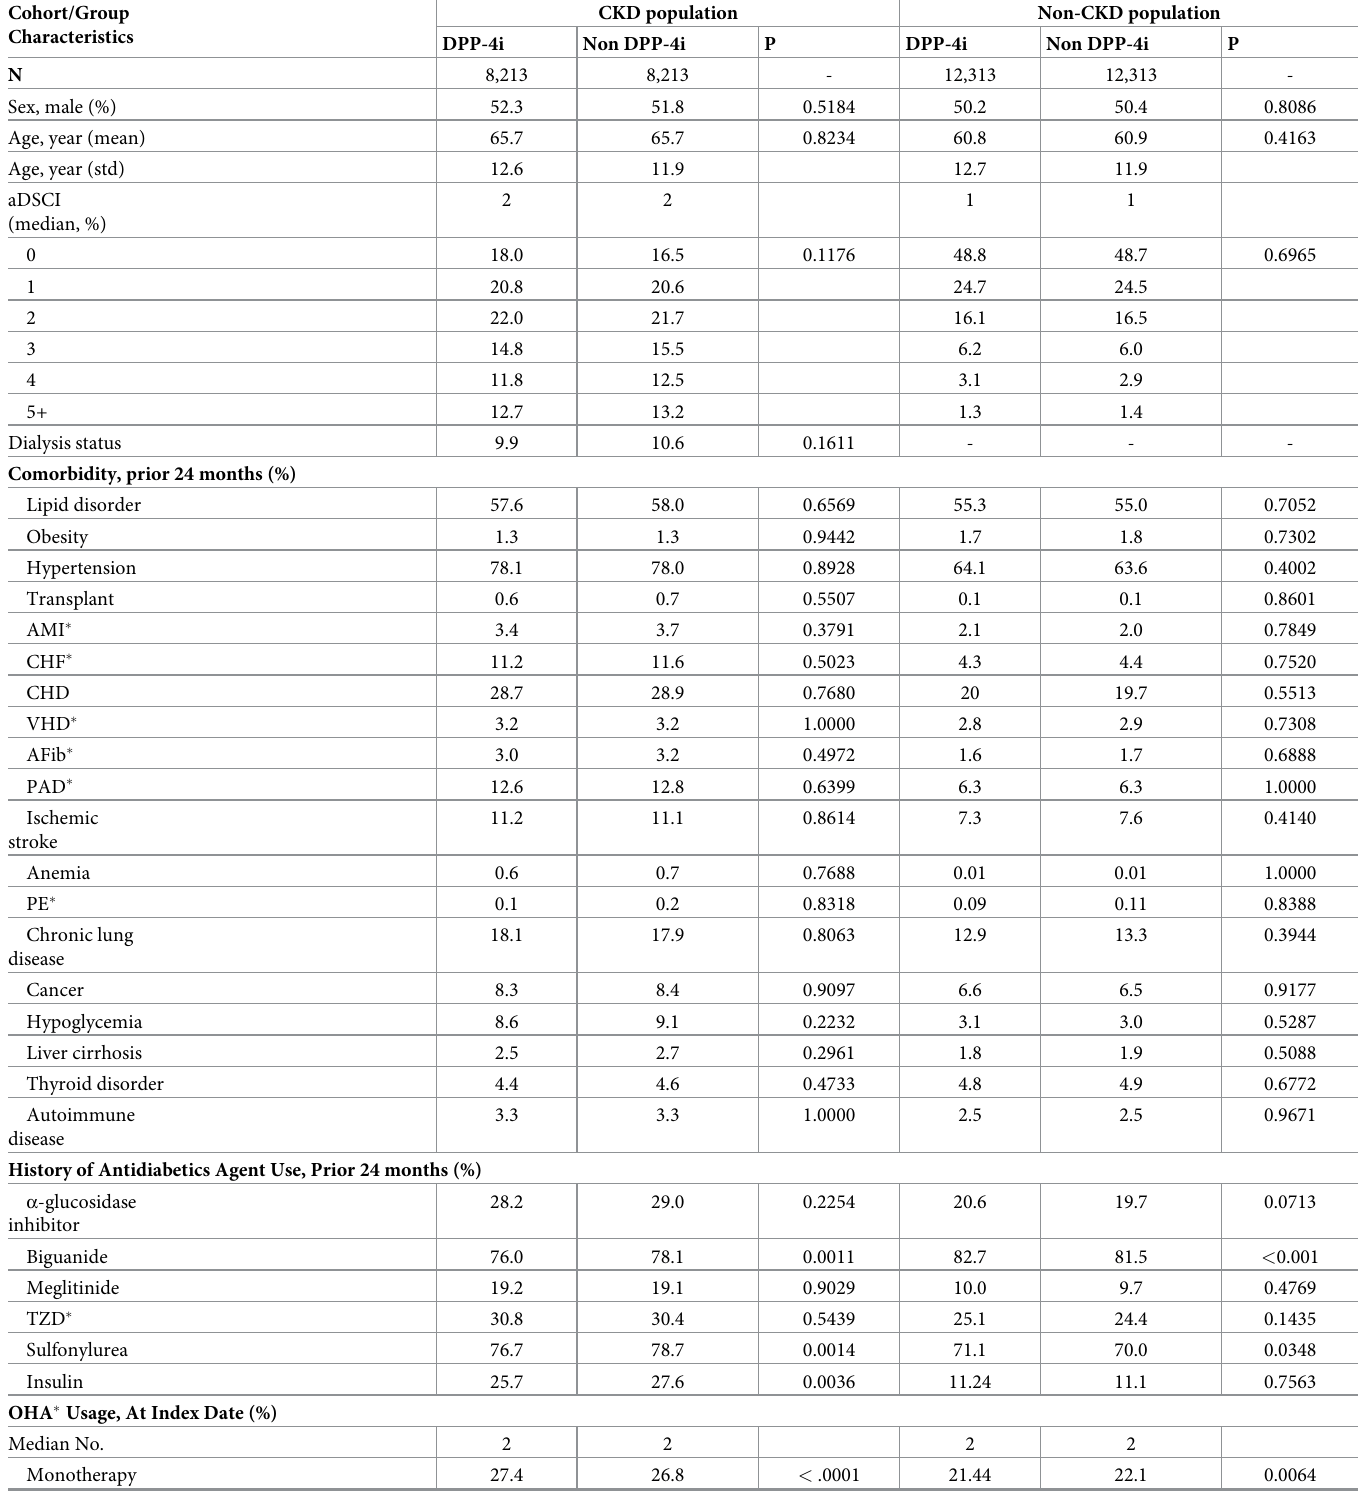
Table 1. Baseline characteristics of study cohort after